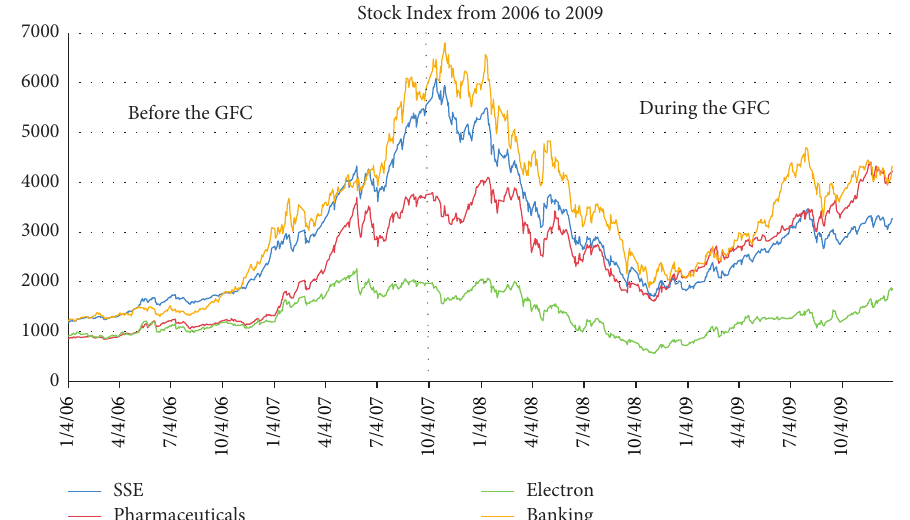
Figure 1: The stock index of the pharmaceuticals, electronics, and banking sectors, and the SSE composite index, 2006 to 2009.